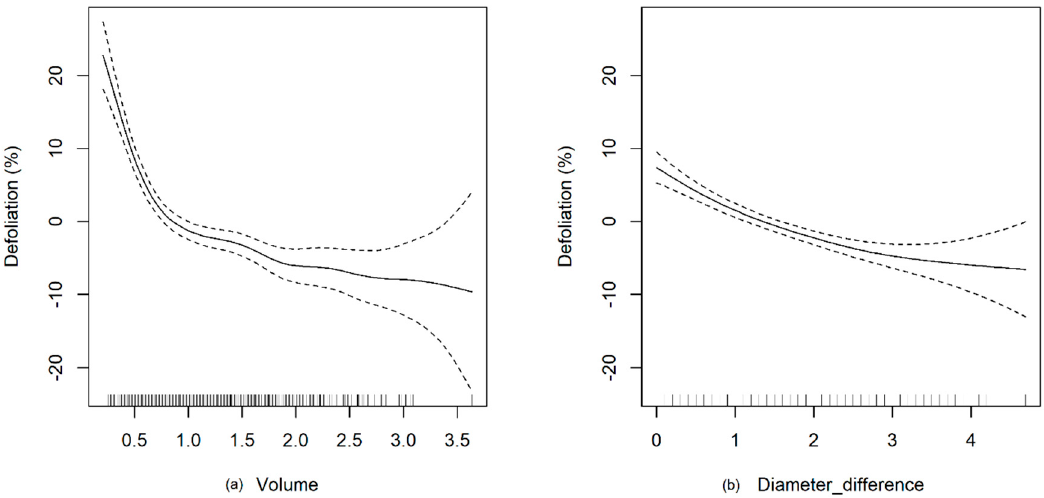
Figure 3. Relationship between defoliation and volume ( a ) resp. diameter difference ( b ), using non-parametric smoothers in generalized additive model. On the y-axis are the differences from the average defoliation = 37%.